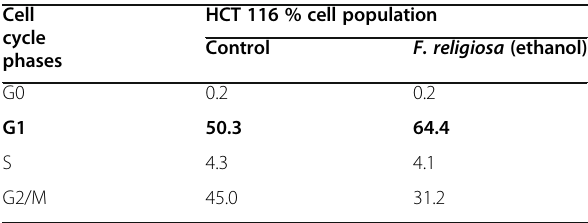
Table 7 The % cell population of HCT 116 cells at different phases of cell